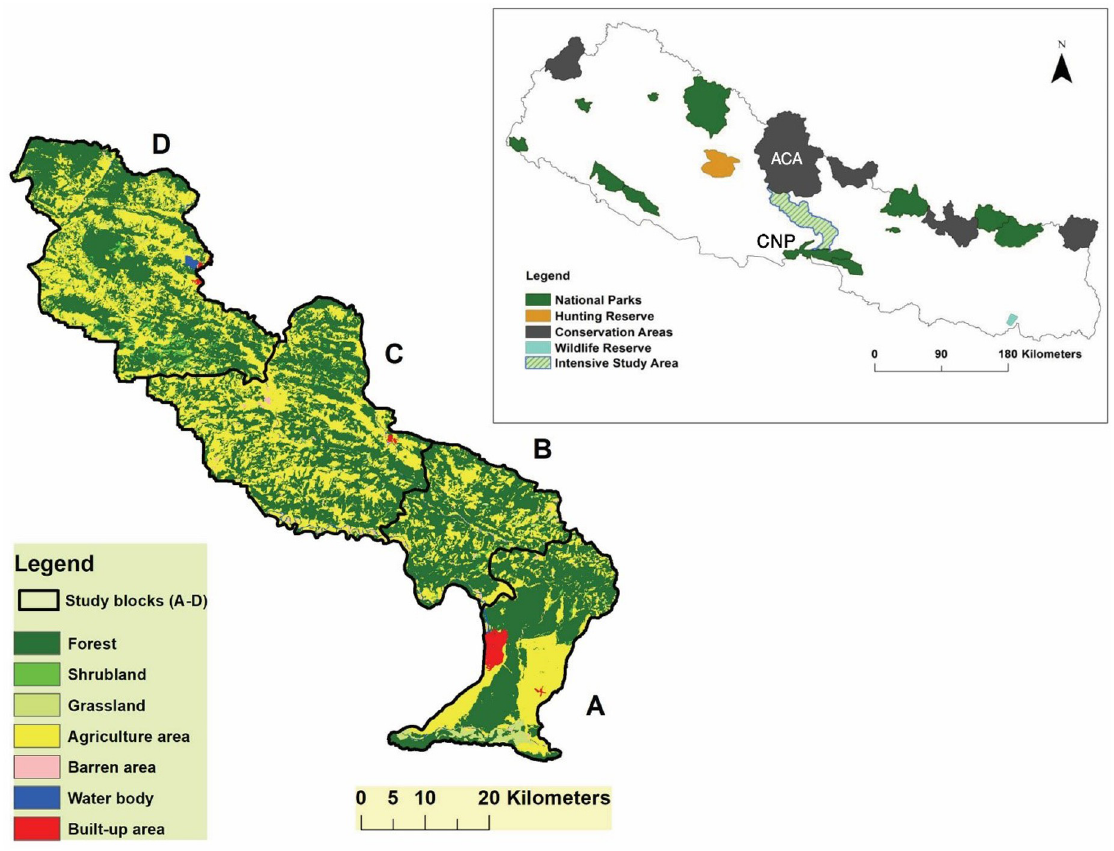
Fig 1. The map shows the intensive study areas which links two biodiversity significant areas: Chitwan National Park (CNP) and Annapurna Conservation Area [52].